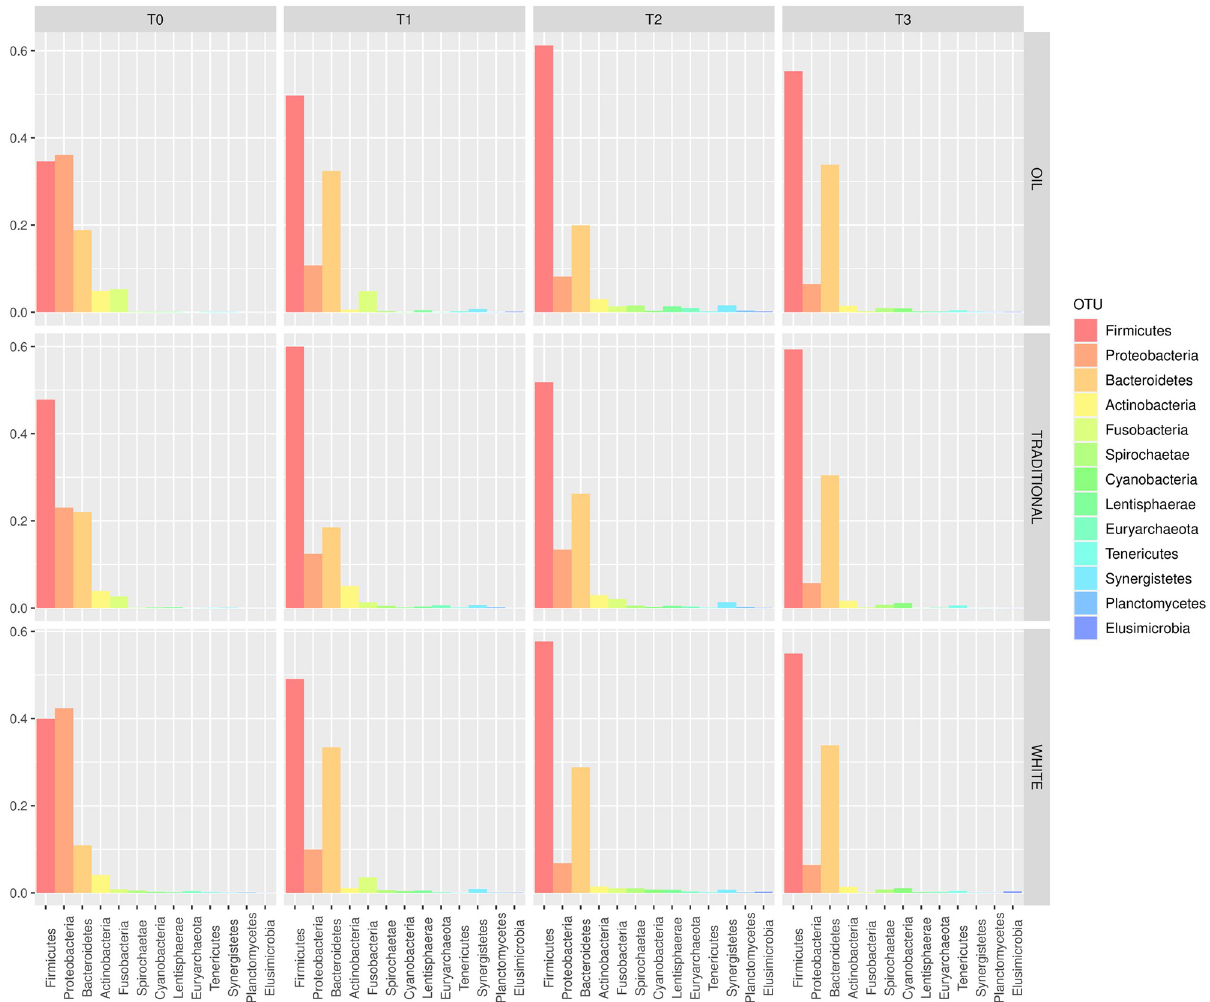
Fig 1. Phylum distribution. Relative abundance of phyla per treatment and timepoint in the gut microbiota of piglets.